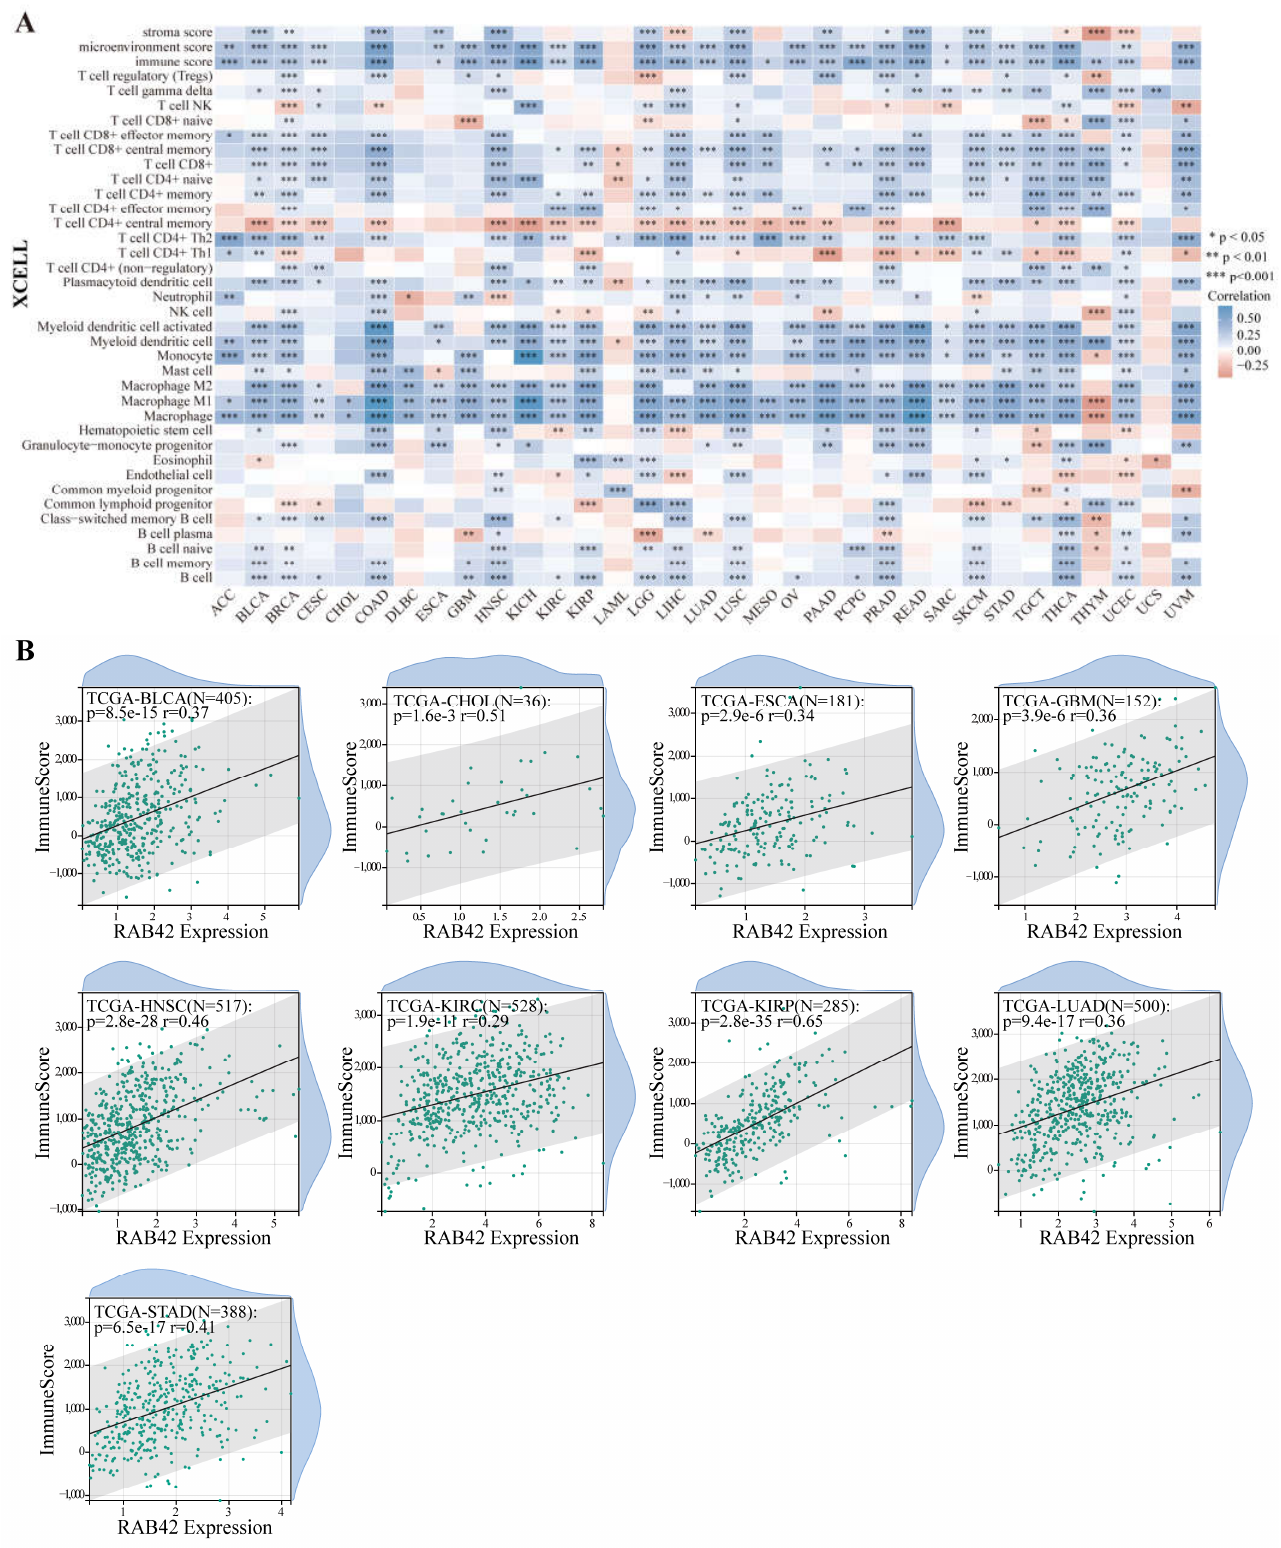
Figure 6. Correlation analysis between RAB42 expression and immune cell infiltration. ( A ) Spear- man’s correlation between RAB42 expression and immune cell infiltration in pan-cancer. (XCELL algorithm); ( B ) Spearman’s correlation between RAB42 expression and immune score. * p < 0.05, ** p < 0.01, and *** p < 0.001.